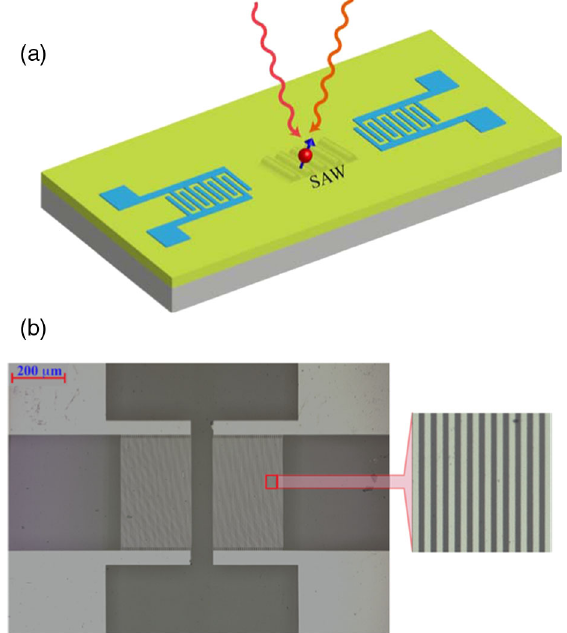
FIG. 2. (a) Schematic of a NV center driven by two optical fields and a SAW field generated by an IDT. (b) Optical image of a pair of IDTs fabricated on the diamond